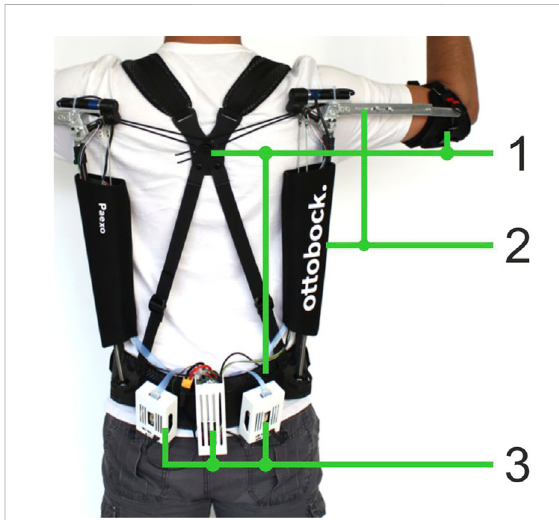
FIGURE 1 Adaptive Paexo Shoulder as worn by a participant. 1) Textile support structure, 2) assistive structure, and 3) control electronics including power source.